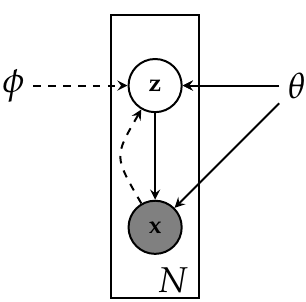
Figure 8. Graphical model for the VAE: Solid lines denote the generative model p θ ( z ) p θ ( x | z ) , dashed lines denote the variational approximation q φ ( z | x ) to the intractable posterior p θ ( z | x )